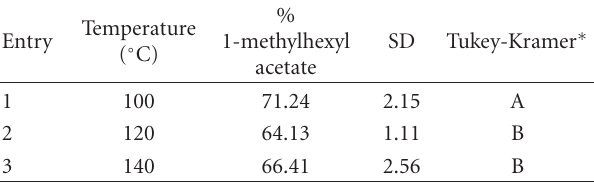
Table 3: E ff ect of the temperature on the synthesis of 1-methylhexyl acetate. Reaction conditions: 1 :1 molar ratio acetic acid :alcohol,